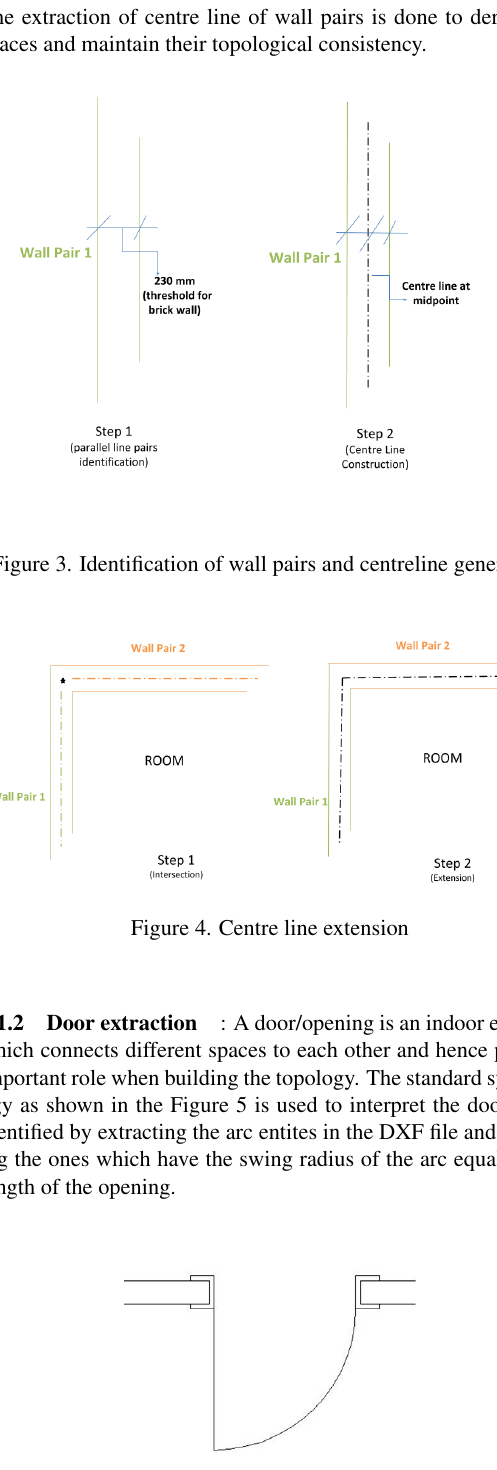
2.1.3 Text information : A lot of labels are associated